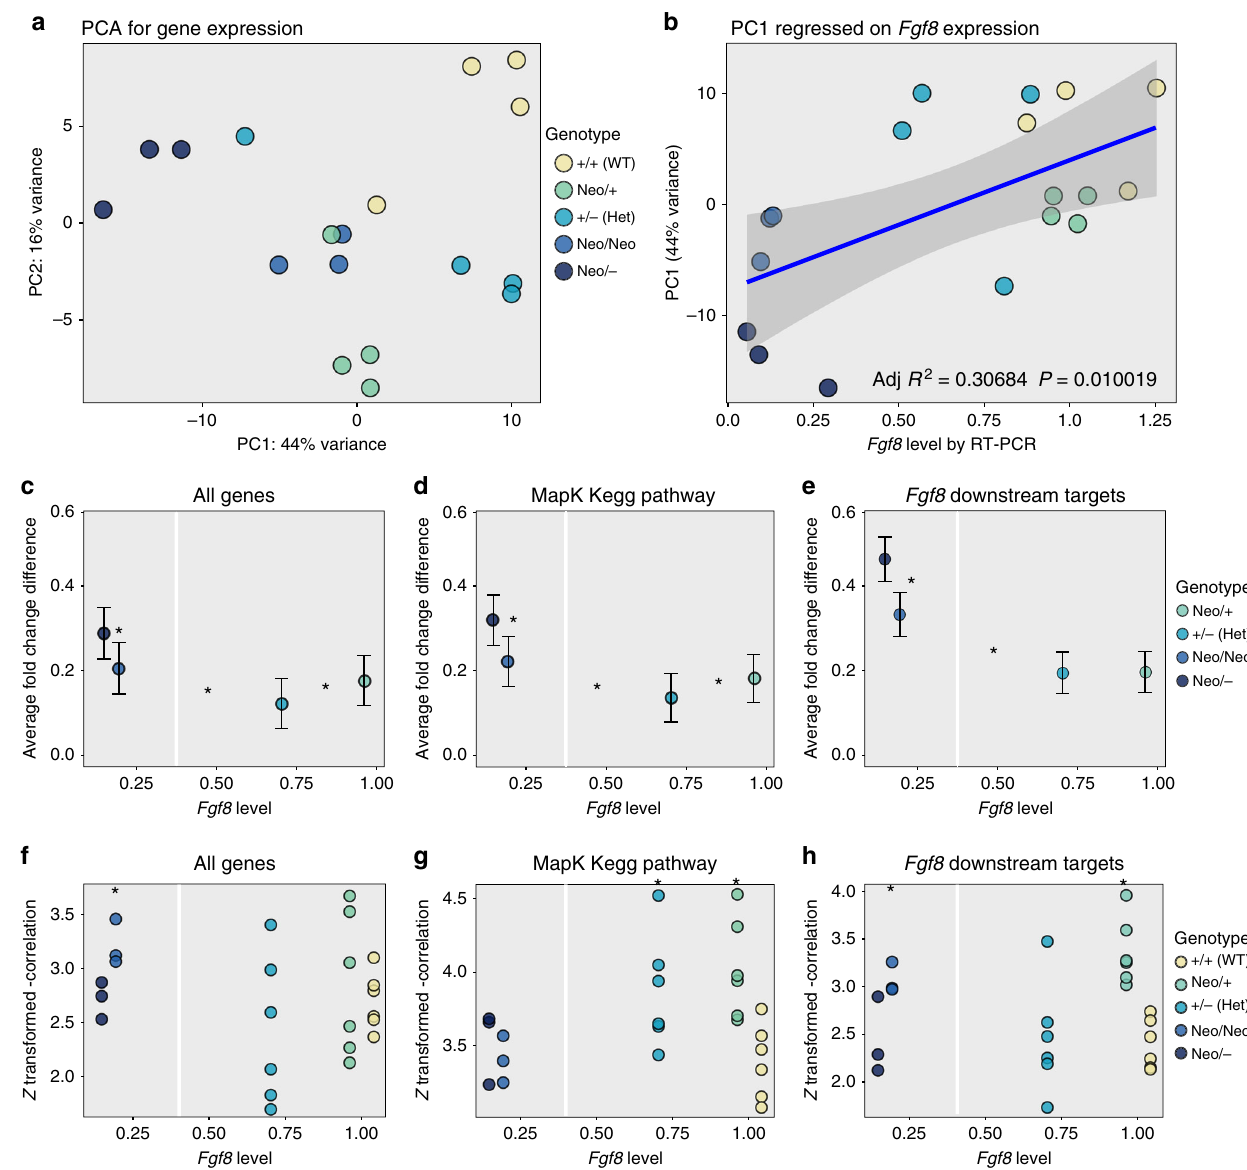
Fig. 6 Gene expression changes across the Fgf8 allelic series. a PC 1 and 2 plot of RNAseq data (18 samples). No differences in dispersion are observed between groups. b Relationship between PC1 of the RNAseq data and Fgf8 level for each sample as quanti fi ed by RT-PCR. The blue line shows the line of best fi t, gray shows the 20% error around the line. c – e Average absolute value fold change (dot) and average absolute value standard error of the fold change (error bar) between each mutant genotype and wild type, c all measured genes, d MapK Kegg gene list (174 genes), and e Fgf8 downstream targets (15 genes). The asterisk represents P < 0.05 (bootstrap resampling) between nearest-neighbor groups (shown between the groups). The white vertical line shows an Fgf8 level of ∼ 40%. f – h Z-transformed covariance between each embryo within a genotype on f all genes, g MapK Kegg gene list (174 genes), and h 15 known Fgf8 downstream targets (Supplementary Table 3). The asterisk represents P < 0.05 (bootstrap resampling) between group and wild